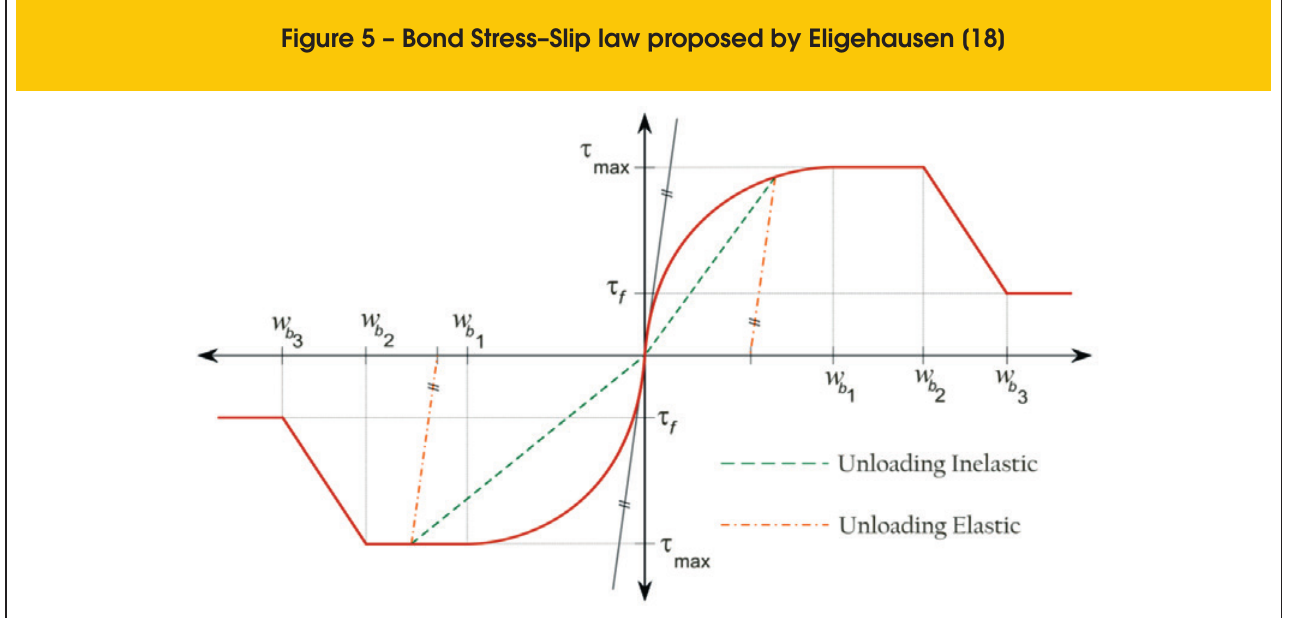
Figure 5 – Bond Stress–Slip law proposed by Eligehausen